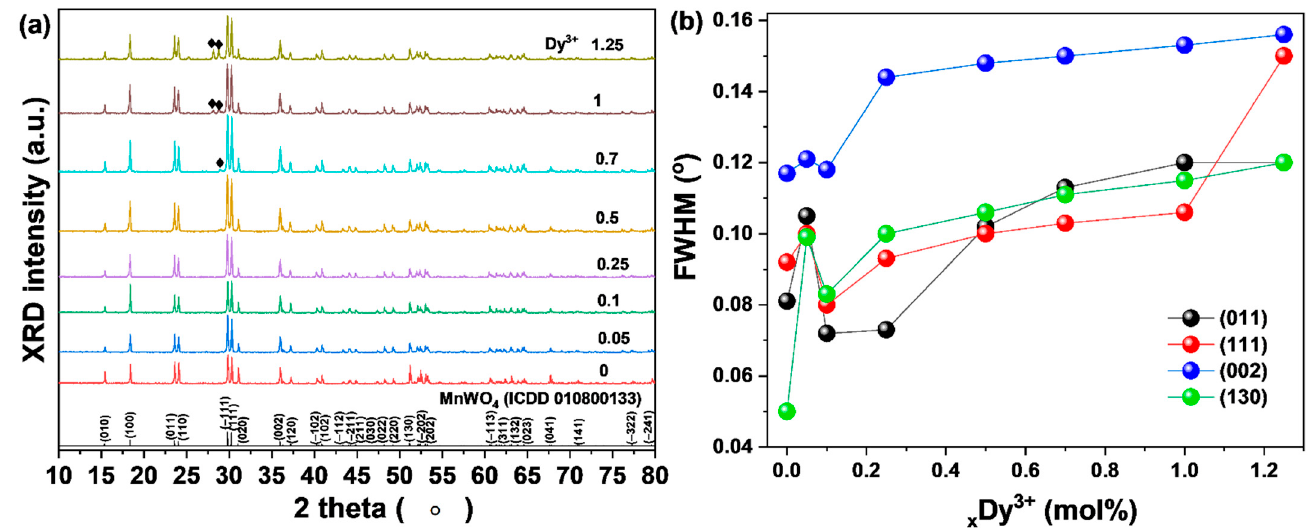
Figure 3. ( a ) XRD patterns of MnWO 4 :Dy 3+ and ( b ) change of FWHM. Raman analysis was performed to double check the XRD data obtained for Dy 3+ ion- doped crystalline MnWO 4 . The vibration bands of MnWO 4 shown in Figure 4a show six Raman active modes at 200, 320, 391, 539, 691, and 878 cm − 1 , This may be due to the ν (A g ), r(B g ), δ (A g ), symmetric A g , (W 2 O 4 ) n chain, ν as (B g ) of the Mn cation, and the symmetric A g oscillations of the two terminal WO groups, respectively. There is crystalline MnWO 4 , which correlates accurately with the literature [16]. The very strong band appearing at 878 cm-1 corresponds to the strong symmetrical stretching of the WO 2 group in MnWO 4 . The bands at 769 and 691 cm − 1 indicate the existence of weak asymmetric and symmetric tensile vibration modes of W–O–W bonds [17]. The peak at 539 cm − 1 is attributed to the tensile vibration of Mn–O [18]. The band at 391 cm − 1 indicates that there is a symmetric stretch of W–O–W [19]. The band at 320 cm − 1 checked the moderate shear of WO 2 and W–O–W [20]. The weak vibrating band appears at 251 cm − 1 , indicating the bending mode of [WO 6 ] 6 and the twisting vibrating mode of the WO 2 group [21]. The two vibrating bands at 158 and 121 cm − 1 are translational modes of tungsten [22]. In Raman analysis, no significant change was observed between the MnWO 4 :Dy 3+ and MnWO 4 samples. To identify changes in the MnWO 4 , vibrating sample magnetometer (VSM) analysis was performed (Figure 4b).